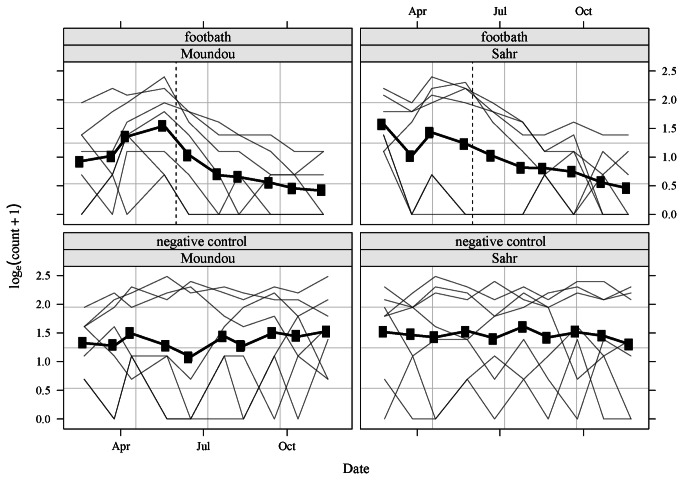
Tsetse total catches (log scale) at the treatment (top) and control (bottom) sites in the two regions of southern Chad.The black line represents the mean observed values; the light grey lines depict the observed values for the individual traps, and the black vertical dashed line indicates the start of footbath treatments.